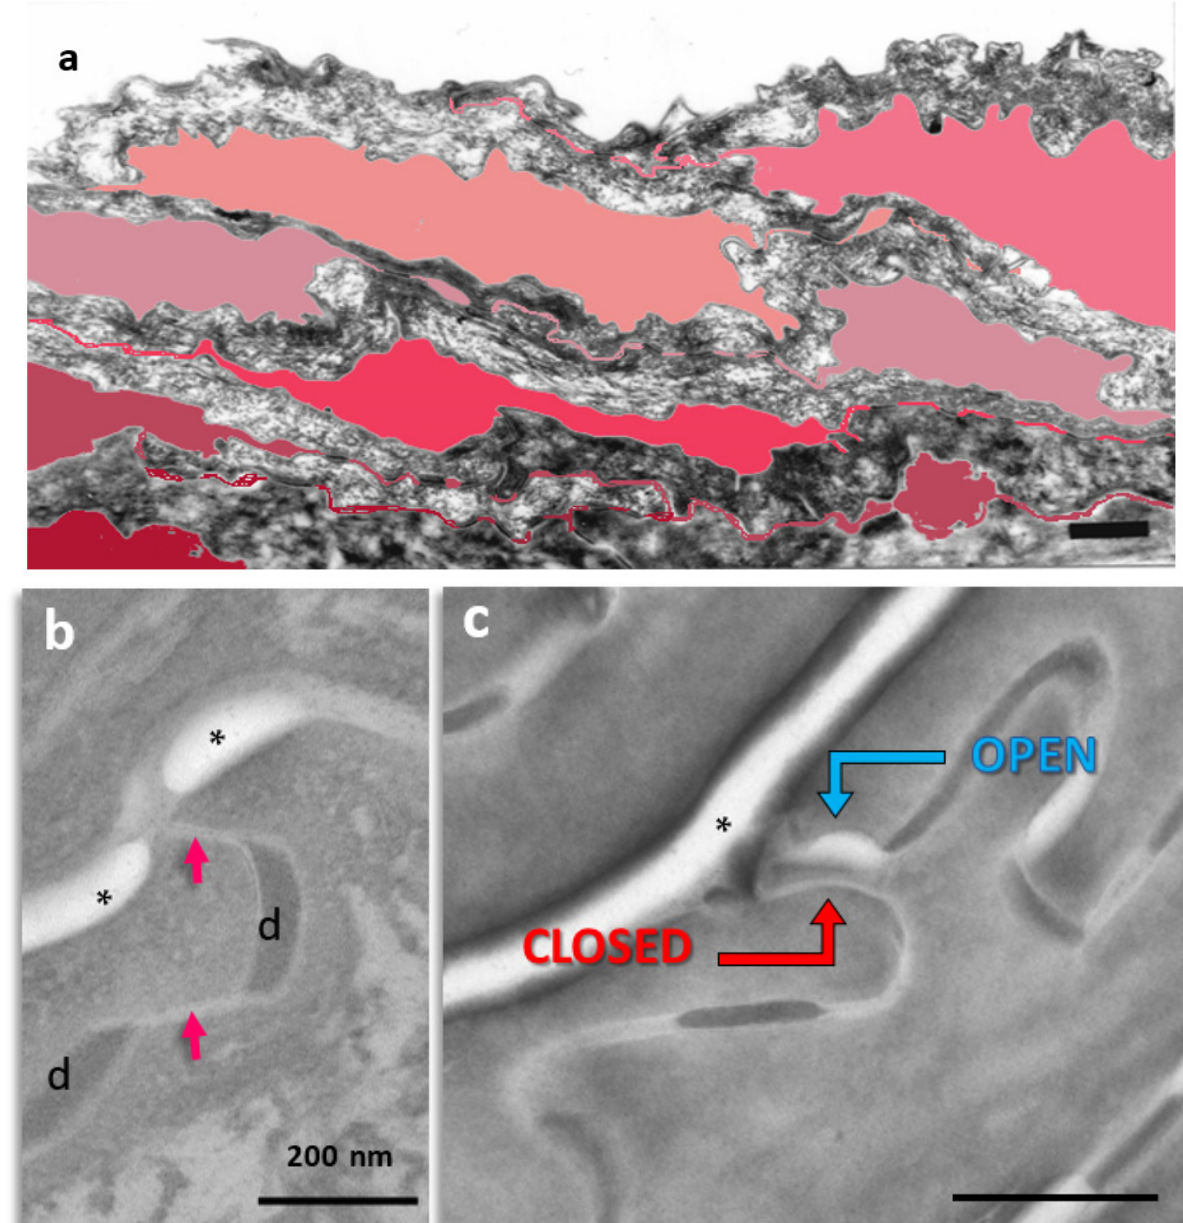
Figure 1. Subdivision of the extracellular space of SC into separate compartments, ( a ) indicated in different colors; ( b ) apical-lateral TJ remnants (arrows) intercalating corneodesmosomes (d) may be quantified; ( c ) an example of “closed” and “open” apical-lateral contacts between the three SC 2 corneocytes. TJ-derived fusions of corneocyte envelopes seal the extracellular space (*). Bar in ( a ) = 1 µm; in ( b , c ) = 200 nm.